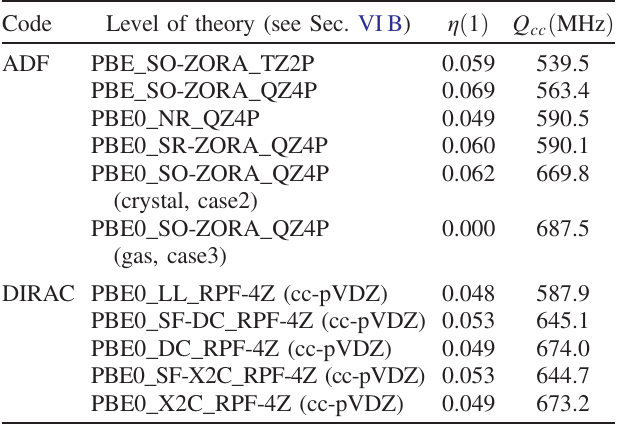
for 209 Bi in this complex, the so-called ZORA-4 scalar TABLE II. Changes of Q cc and η in a single triphenylbismuth